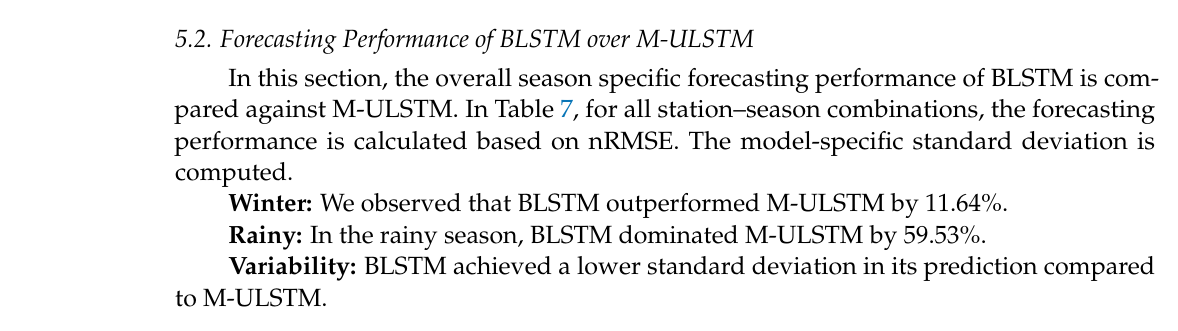
Table 7. The forecasting performance of BLSTM and M-ULSTM measured on